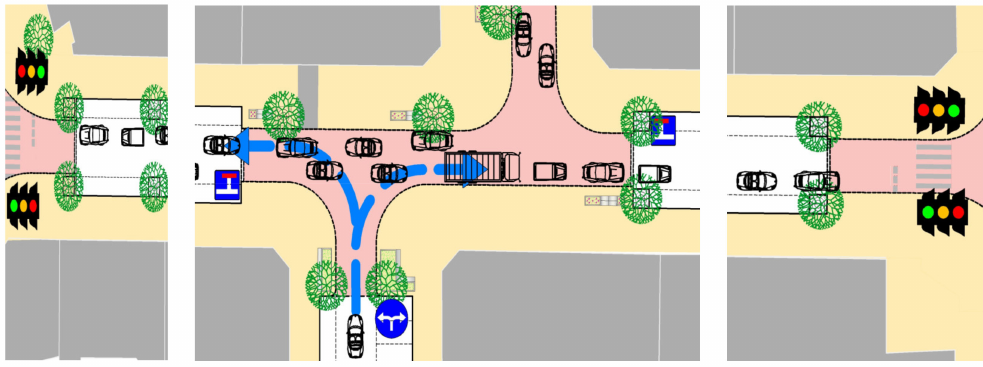
Figure 12. Traffic conditions and existing traffic management at the end of testing ground No. 3. Source: own work of the author based on